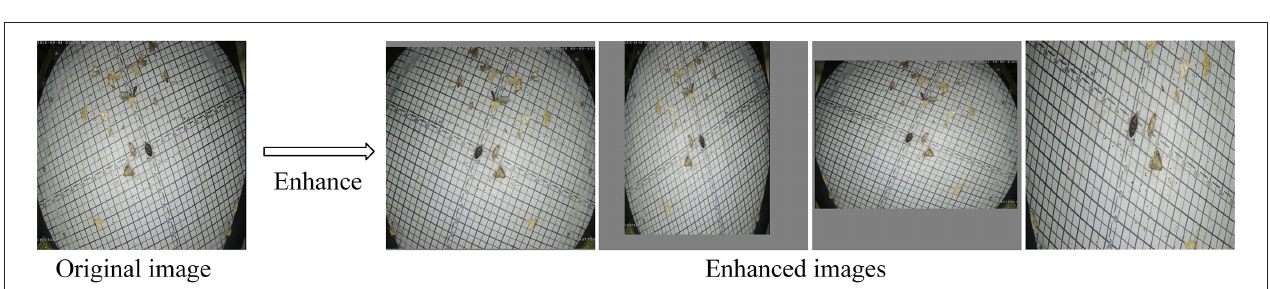
FIGURE 2 | Original image and Enhanced images, where Enhanced images are images generated from different batches of original images after image enhancement operations. The Enhanced images in the figure represent the four images generated under four batches.